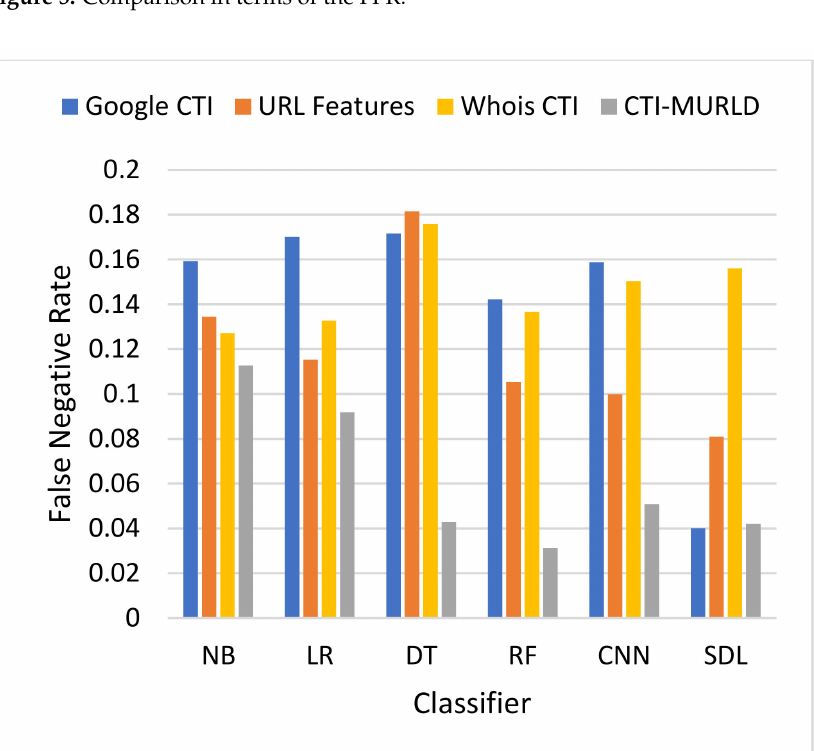
Figure 6. Comparison in terms of the